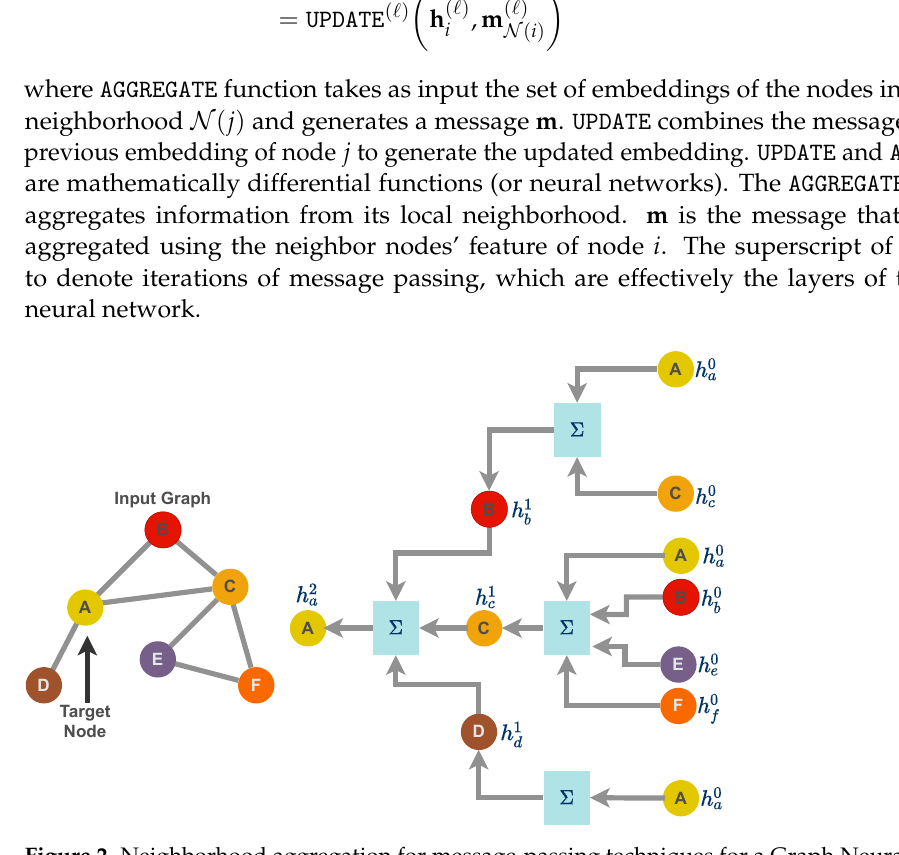
Figure 2. Neighborhood aggregation for message-passing techniques for a Graph Neural